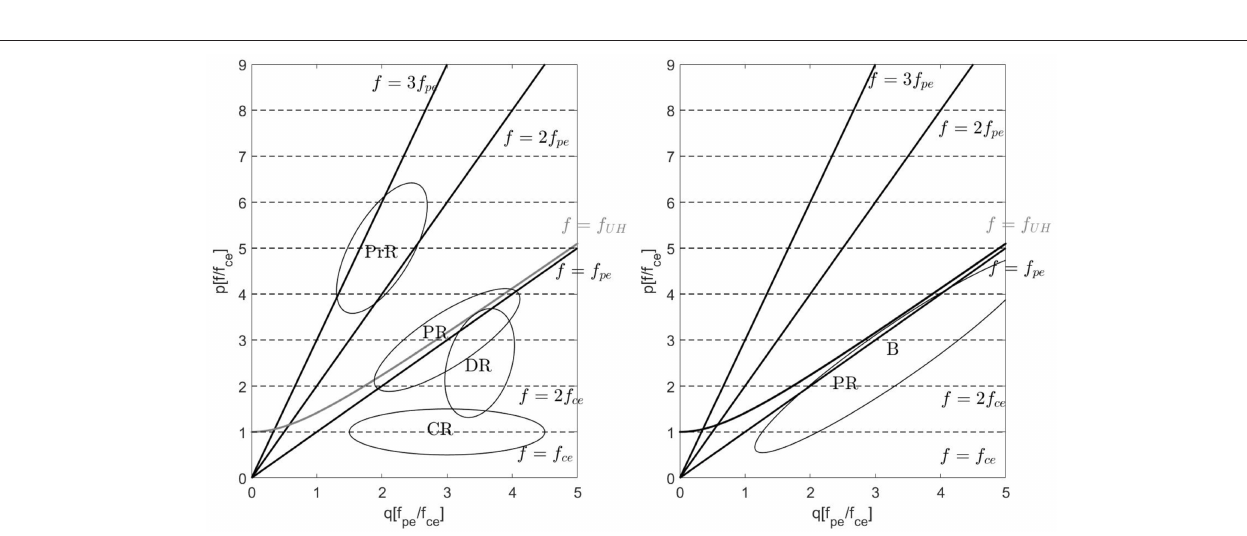
FIGURE 2 | The ASPERA-3 ions (Top) and electron (Bottom) measurements during MARSIS operations. White boxes indicate the 1.257 s time periods when MARSIS was scanning over frequencies. The fluxes of both accelerated ions and electrons correlate well with the periods when MARSIS was transmitting.